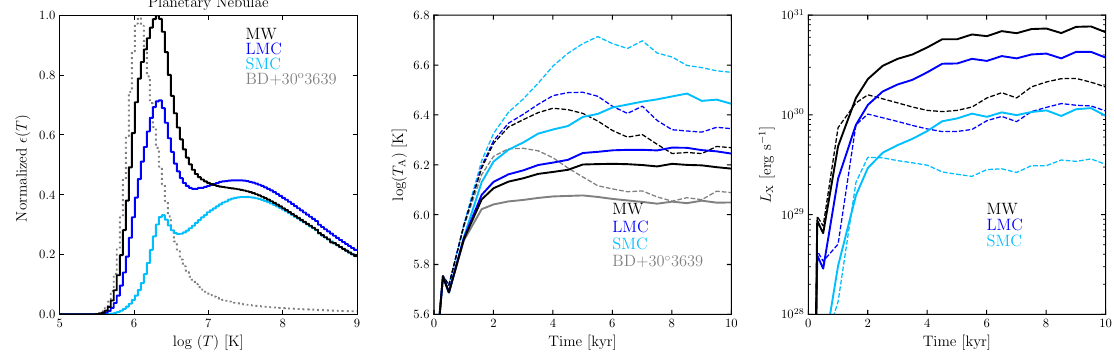
Figure 2. ( Left ) Emission coefficient for the 0.3–2.0 keV energy range for different PNe abundance sets; ( Middle ) evolution of the emission-coefficient-weighted mean temperature of simulated PNe for a 1.5 M (cid:12) progenitor star for different abundance sets; and ( Right ) evolution of the X-ray luminosity for the same models presented in the middle panel. In the middle and right panels, solid (dashed) lines correspond to simulations with (without) thermal conduction. See [13] for